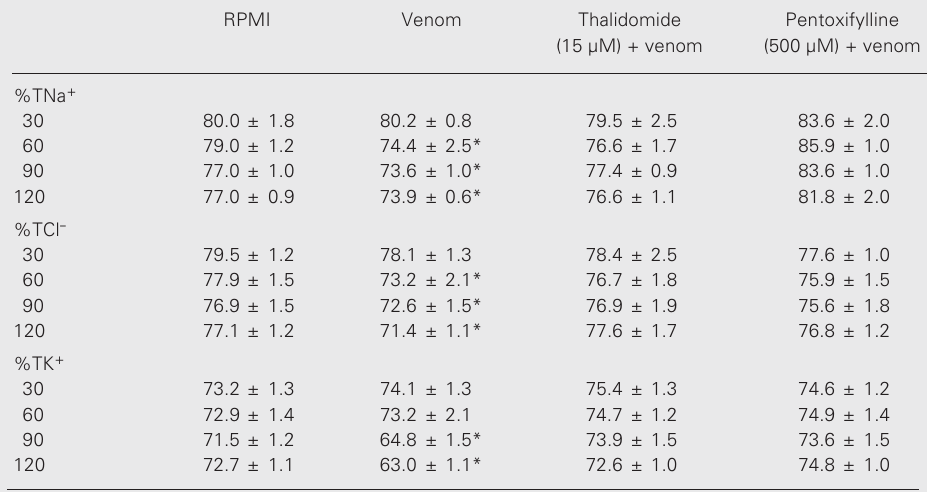
Table 2. Thalidomide and pentoxifylline inhibit the renal tubular effects of the supernatant of macrophages stimulated with Crotalus durissus cascavella venom. RPMI Venom Thalidomide